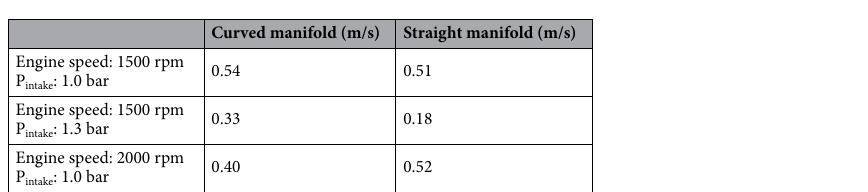
Table 4. Spark plug gap velocity difference between cylinders at TDC.